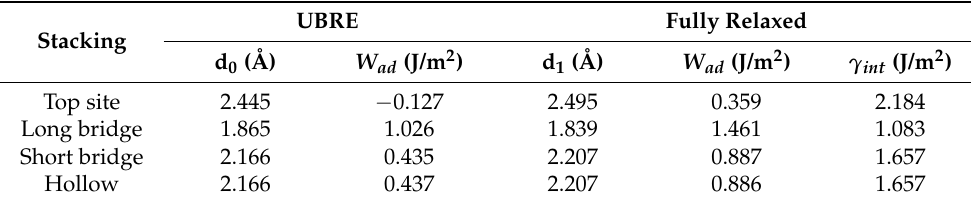
Table 2. The interfacial distance (d 0 , d 1 ), adhesion work ( W ad ), and interfacial energy ( γ int ) of different Cu(200)/AuCu(200) interfaces under unrelaxed and relaxed conditions were